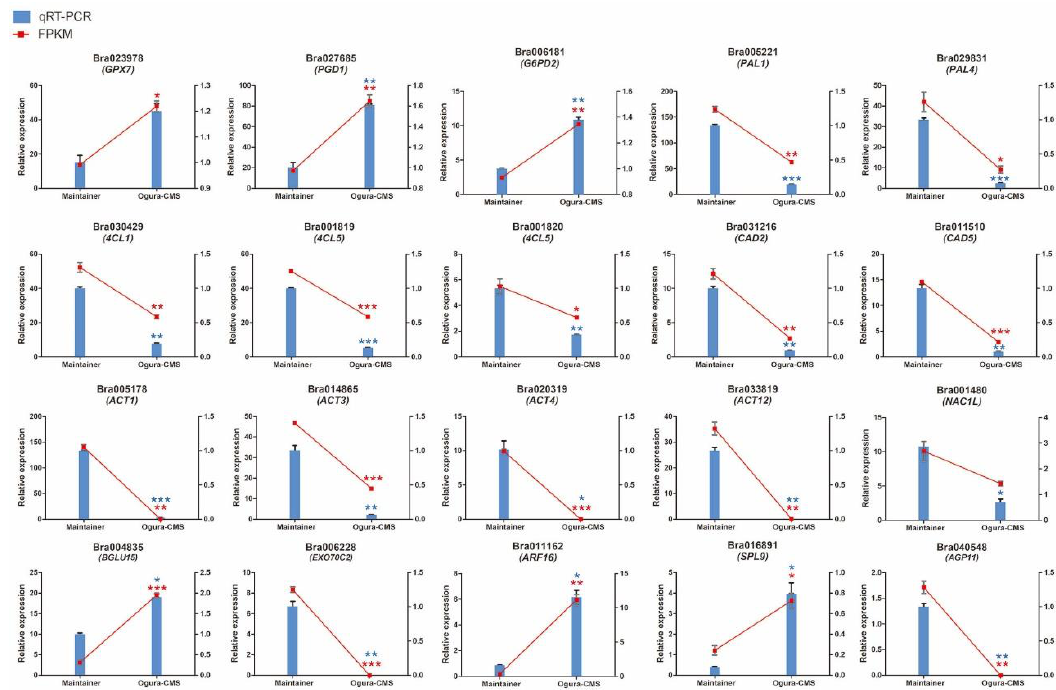
Figure 7. qRT-PCR validation of selected DEGs. The blue columns represent qRT-PCR results and the red lines represent RNA-seq results. GPX7 : glutathione peroxidase 7; PGD1 : glucose 6-phosphate dehydrogenase 1; G6PD2 : glucose 6-phosphate dehydrogenase 2; PAL1 : phenylalanine ammonia-lyases 1; PAL4 : phenylalanine ammonia-lyases 4; 4CL1 : 4-coumarate-CoA ligase 1; 4CL5 : 4-coumarate-CoA ligase 5; CAD2 : cinnamyl alcohol dehydrogenase 2; CAD5 : cinnamyl alcohol dehydrogenase 5; ACT1 : actin 1; ACT3 : actin 3; ACT4 : actin 4; ACT12 : actin 12; NAC1L : NAC1-Like; BGLU15 : beta glucosidase 15; EXO70C2 : exocyst subunit Exo70 family protein C2; ARF16 : auxin response factor 16; SPL9 : squamosa promoter binding protein-like 9; AGP11 : arabinogalactan protein 11. Student’s t -test was used for statistical analysis of data from the two lines (* p < 0.05; ** p < 0.01; *** p < 0.001).